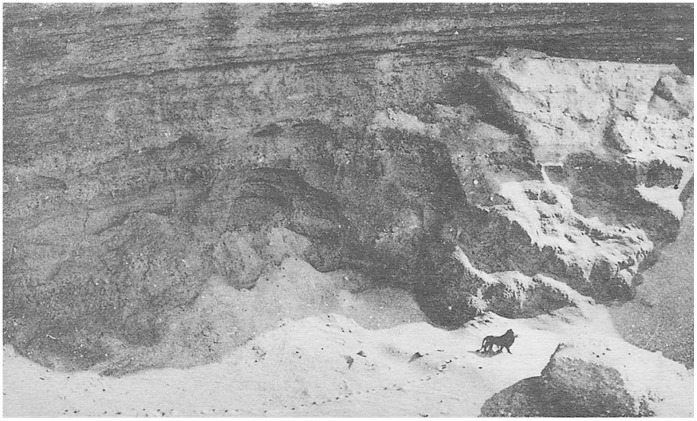
A lion seen in the Atlas Mountains, during a flight on the Casablanca-Dakar air route.The photograph taken by Marcelin Flandrin in 1925 is the last visual record of a wild ‘Barbary’ lion of North Africa.